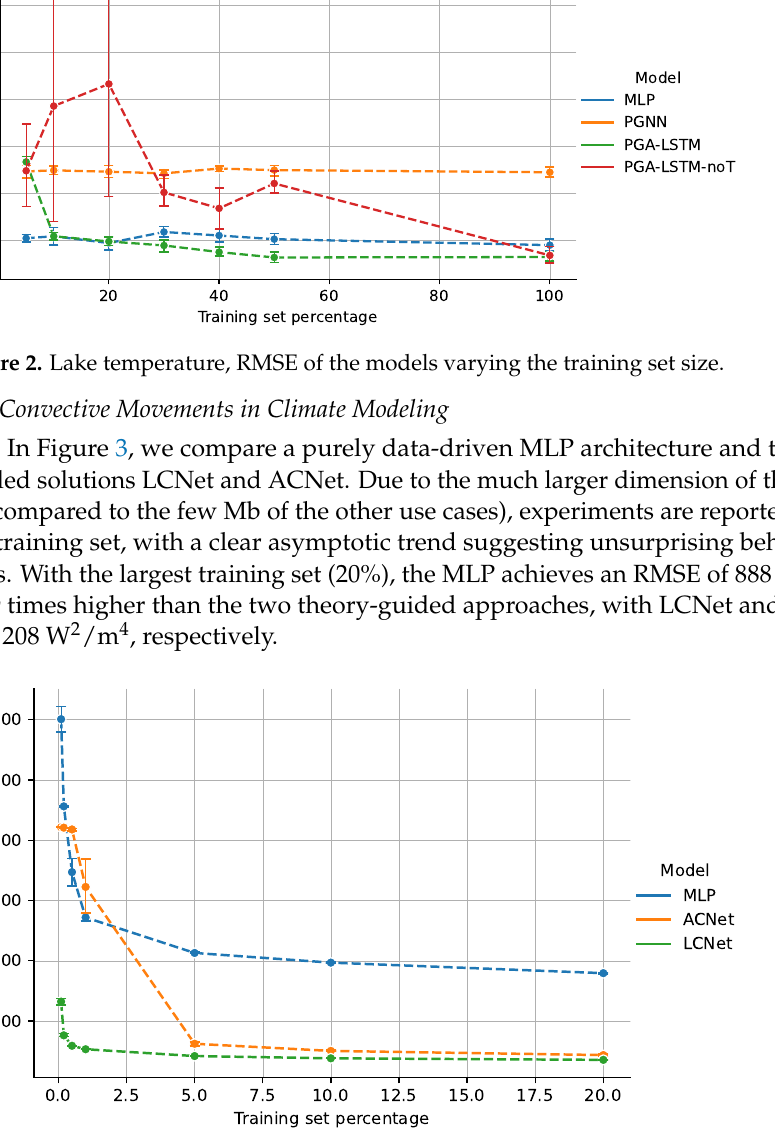
Figure 3. Convective modeling, RMSE of the models varying the training set